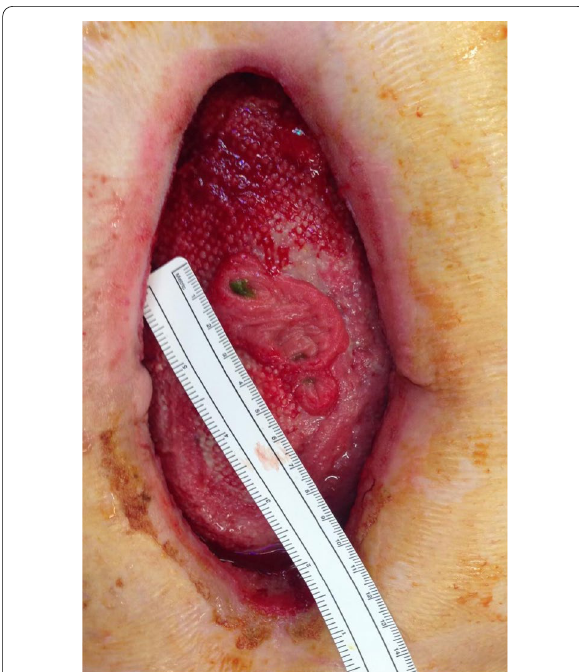
Fig. 1 Early appearance of abdominal wall with fistulae demonstrated Fig. 2 Use of large custom-fit stoma pouch to midline